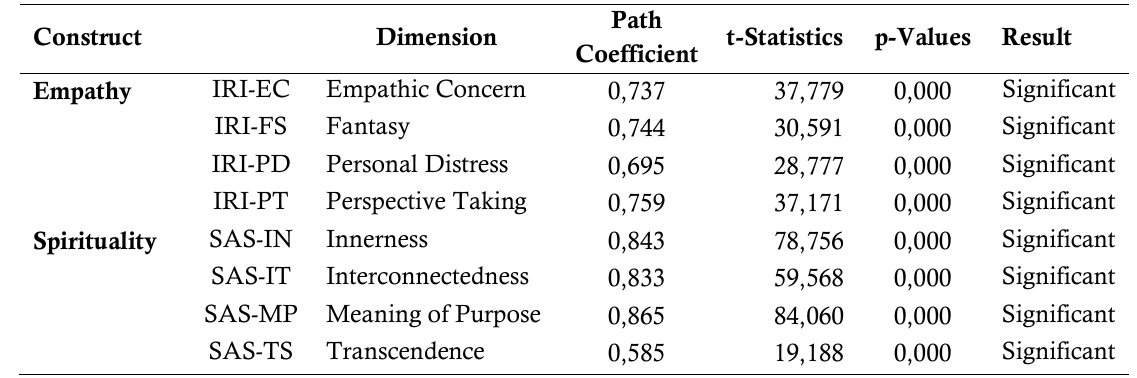
Table 3 . Outer Path Coefficient